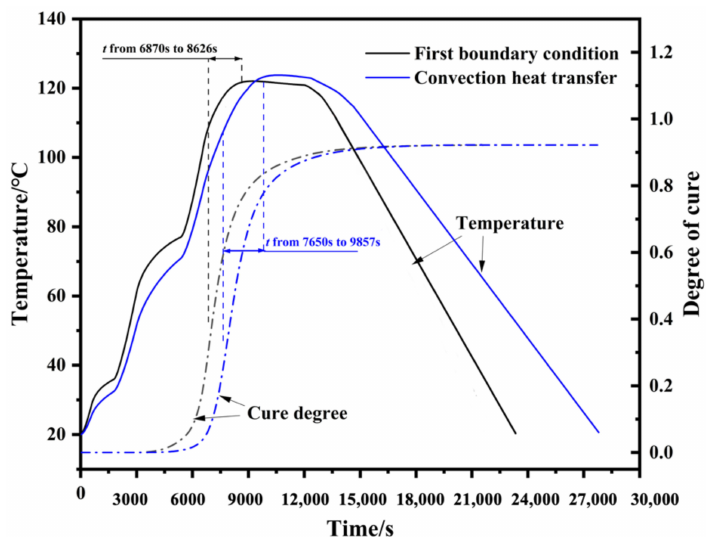
Figure 10. The evolution of temperature and curing degree in the GFRP layer under first boundary condition and convection heat transfer